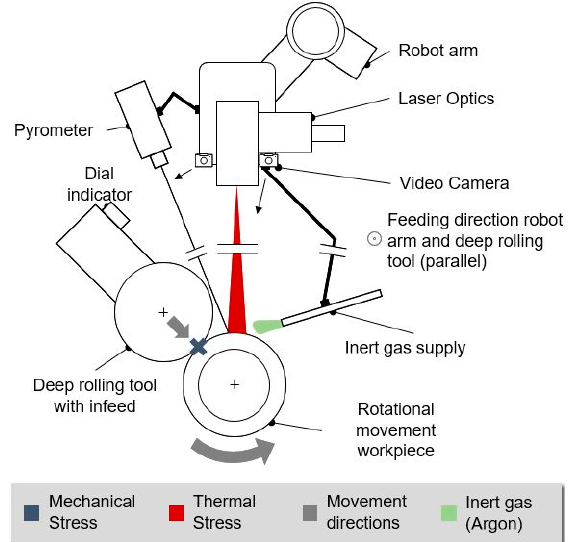
Figure 1. Schematic experimental setup for laser-combined deep rolling.